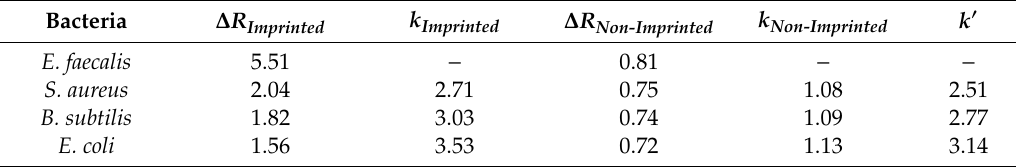
Figure 8. Water sample analyses results. 4. Discussion and Conclusions Careful monitoring of water quality is increasingly needed because fecal contamination is a major health and environmental threat. For many years, the concept of fecal indicator bacteria has been one of the first methods of choice for microbiological risk evaluation of water quality. In general, the indicator bacteria can be enumerated using standard culture-based microbiological methods. E.coli and Enterococcus strains were thought to be good candidates for microbial tracking of water. To this purpose, E.faecalis surface protein-imprinted nanoparticles were prepared and immobilized on the sensor surface for waterborne bacteria detection. In addition, selectivity analyses showed that the specific cavities of the nanoparticles recognize this waterborne bacteria more than other competitor bacteria. The sensor is able to detect in real-time with a low detection limit, and high sensitivity, without the need for labeling. According to the results, this prepared sensor constitutes a highly selective alternative for the detection of microorganisms in environmental pollution for public health control. This study provides an example of more effective alternatives for the detection of microorganisms, such as imprinting of surface protein, pilus, and other antigenic regions. Imprinting of bacterial proteins also eliminates the disadvantages, such as the morphology and size of bacteria, that stand out in whole cell imprinting.